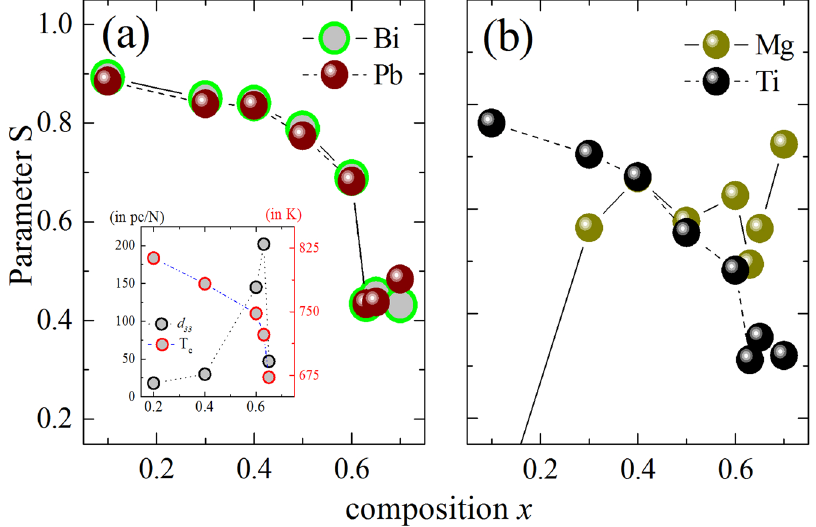
Figure 3. Orientation order parameter S = 1.5 〈 cos 2 θ 〉 − 0.5 showing the degree of deviation of the direction of the cationic off-centre displacements from the [001] pc direction. S gradually decreases in the range x = 0.1 − 0.5 for the A-site cations and Ti, however from x = 0.50 it suddenly drops on the approach to the MPB at x = 0.63. Ti shows comparatively lower values of S, meaning a higher level of disorders. The inset shows the variation of the room-temperature piezoelectric coefficient d 33 and the Curie temperatures as a function of composition 23, 25 . The apparent link between these physical parameters and the observed structural behaviour has been discussed in the